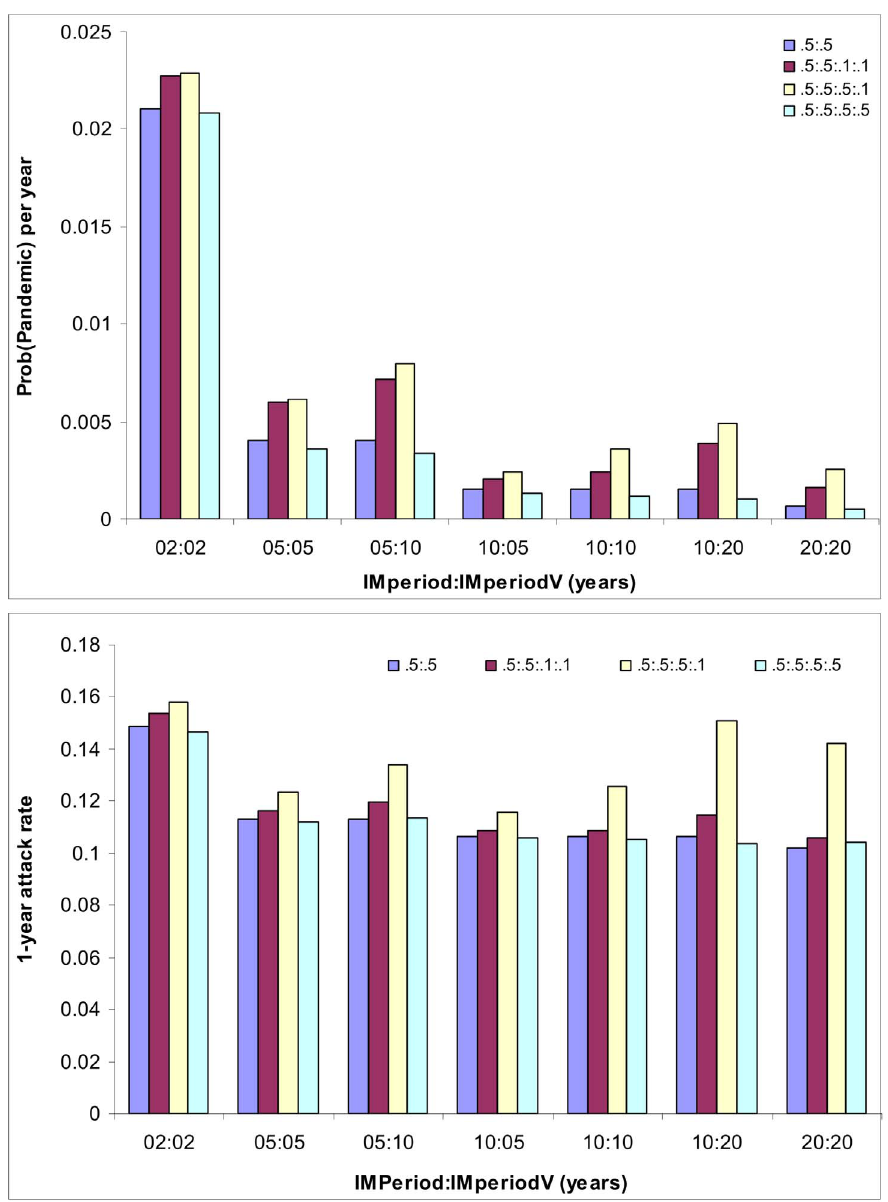
Fig. 3. Impact of cross-immunity and its duration induced by seasonal flu vaccination on the annual emergence probability of pandemic strain via reassortment. The values of other model parameters are as in Table 1. The pairs of numbers are the mean durations, in years, of immunity induced by natural infection and vaccination, respectively. Here we consider a situation of cross-immunity structure where the cross- immunity conferred by vaccination are less than or equal to that by natural infection: Q : y : Q V : y V 5 0.5:0.5:0.1:0.1 (red), and 0.5:0.5:0.5:0.1 (yellow), 0.5:0.5:0.5:0.5 (green). For comparison, the situations without vaccination (blue) are also